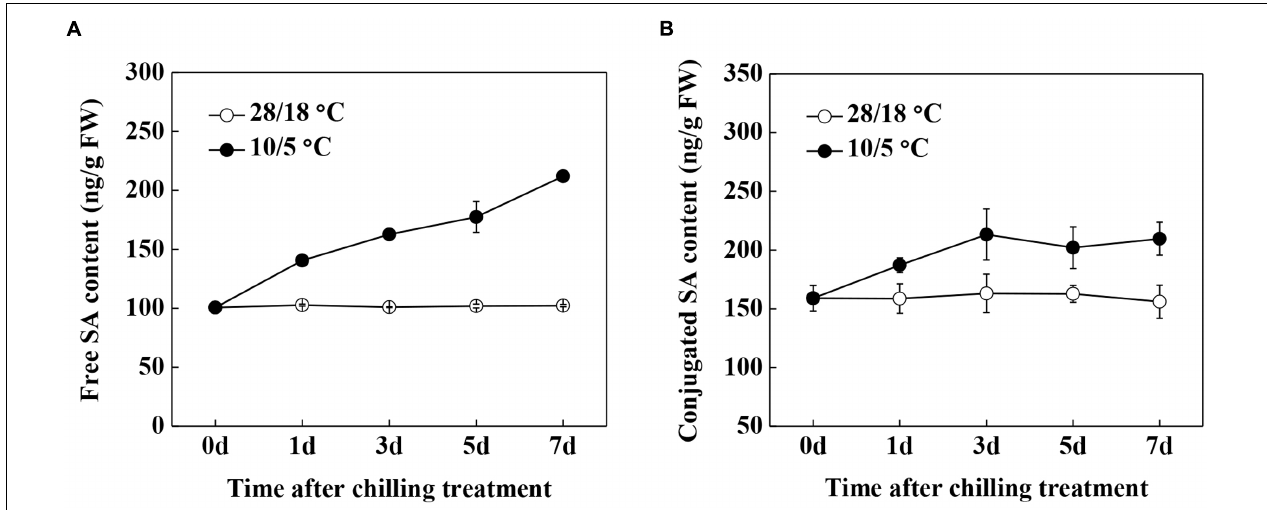
FIGURE 1 | Time course accumulation of SA in response to chilling stress in watermelon. (A) Free SA content. (B) Conjugated SA content. Leaf samples were collected at the indicated times. The data are the means of four replicates with SEs. Different letters indicate significant differences between the treatments according to Tukey’s test ( P <